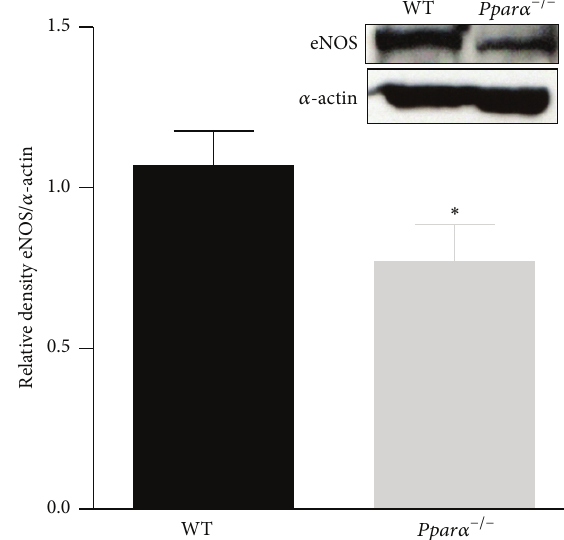
of Ppar 𝛼 −/− mice. Together these data affirm that Ppar 𝛼 −/−